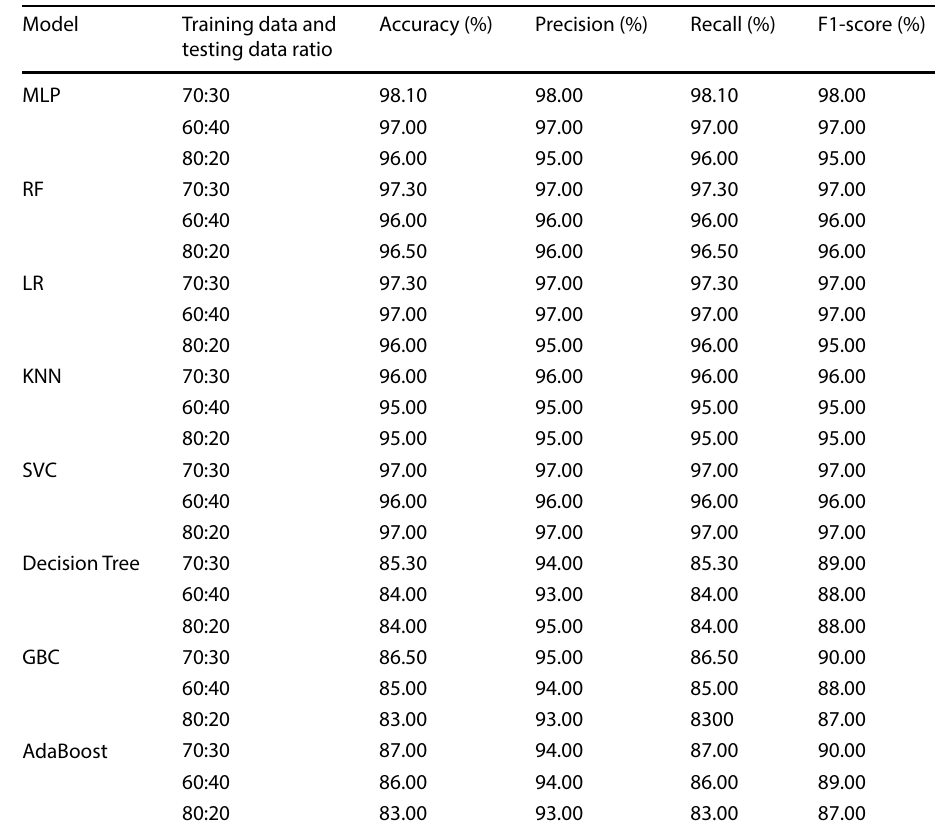
Model Training data and testing data